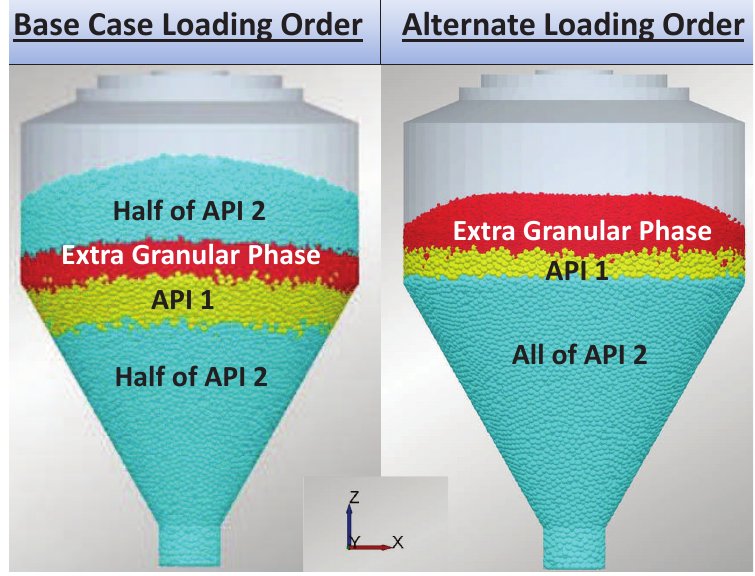
Figure 11. Loading order of the